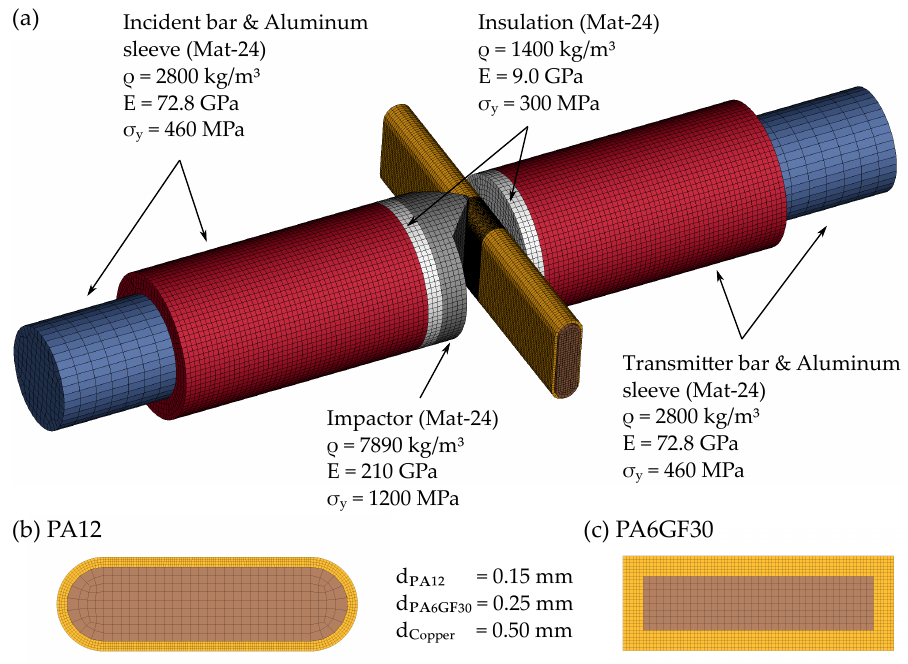
Figure 6. Numerical FE model of the SHPB environment and the HVB: ( a ) Shows the SHPB model in the area of the specimen including the used material models and parameters. ( b , c ) Show the cross-section of the impacted HVBs (PA12 and PA6GF30) with the according element